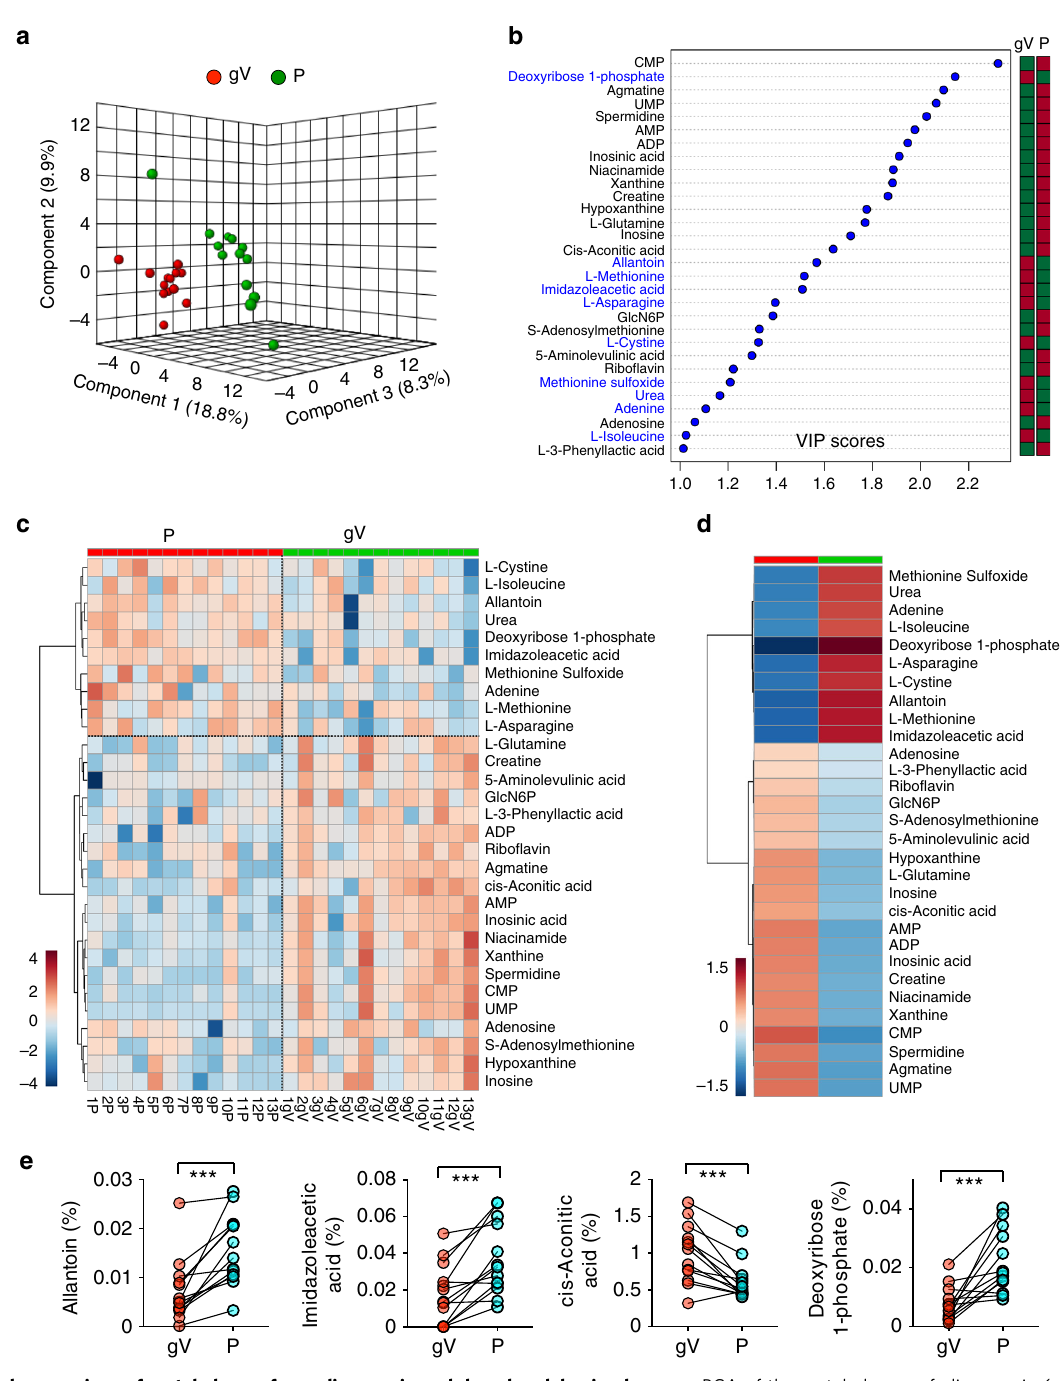
Fig. 4 Paired comparison of metabolomes from glioma vein and dorsal pedal vein plasma. a PCA of the metabolomes of glioma vein (gV) and dorsal pedal vein (P) samples from 13 patients. Three PCs explain 36.9% (9.8%, 18.3%, and 8.8%) of variance and could not separate gV from P. PC scores are indicated as %; circles indicate individual samples from glioma venous blood and dorsal pedal vein samples, respectively. b VIP scores of metabolites between glioma vein and dorsal pedal vein plasma samples. The metabolites enriched in glioma venous blood (gV) are labeled in blue. The columns to the right indicate whether the abundance of each metabolite is enhanced (red box) or reduced (green box) in each plasma group. c A heatmap representation of 30 of 107 metabolites of blood plasma from gV and P samples of 13 patients. Warm color indicates higher concentration. d A heatmap representation of 30 metabolites (VIP score > 1) in blood samples from the glioma vein (gV) and dorsal pedal vein (P). Names of these metabolites are listed on the right side of the map. Color bar (bottom left), warm color indicates higher concentration. e Relative abundance (normalized by TIC, y -axis) of four representative metabolites (Allantoin, Imidazoleacetic acid, cis-Acontic acid, Deoxyribosoe 1-phosphate) from glioma vein (gV) and dorsal pedal vein (P) samples. *** p < 0.001 ; two-tailed paired t